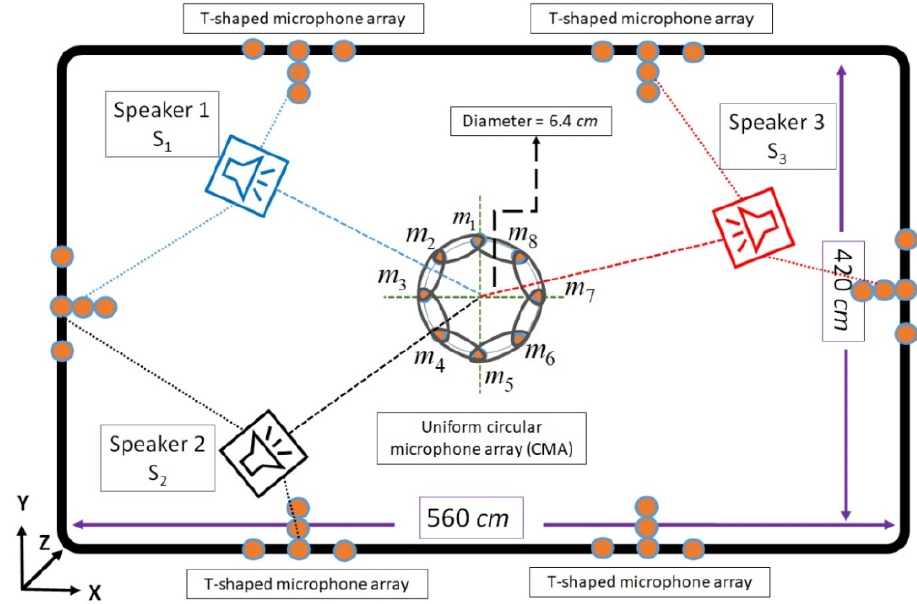
Figure 5. A view of the simulated room with speakers, circular, and T-shaped microphone arrays.